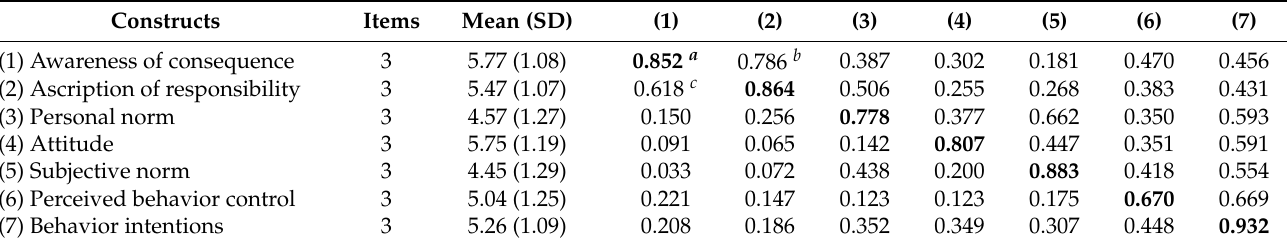
Table 3. Descriptive statistics and associated measures.